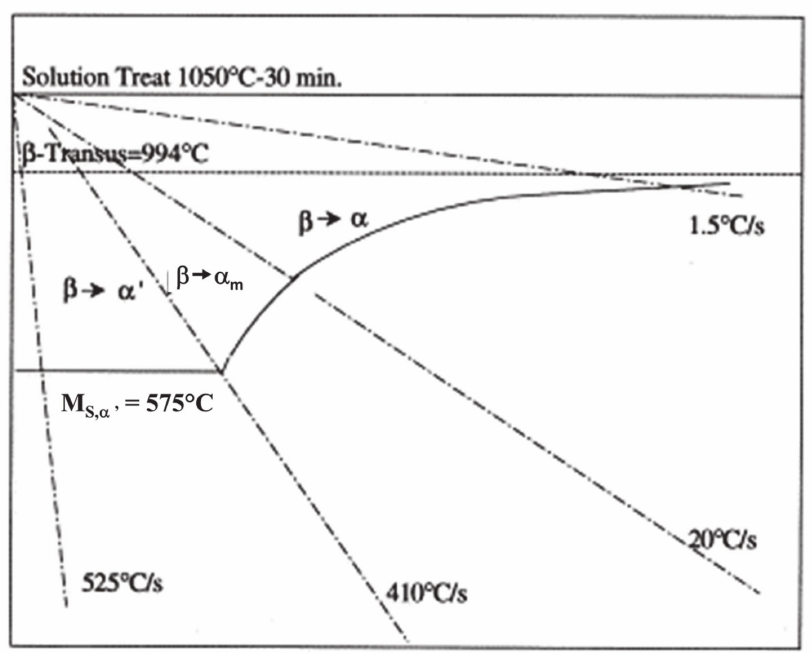
Figure 2. Schematic CCT diagram with only the starting points of the transformations of parent β phase and their related critical cooling rates both α m . and α phases with a DDfT and DDsT, respectively, for the related transformation products. Adapted with permission from ref. [54]. Copyright 1998 Elsevier.